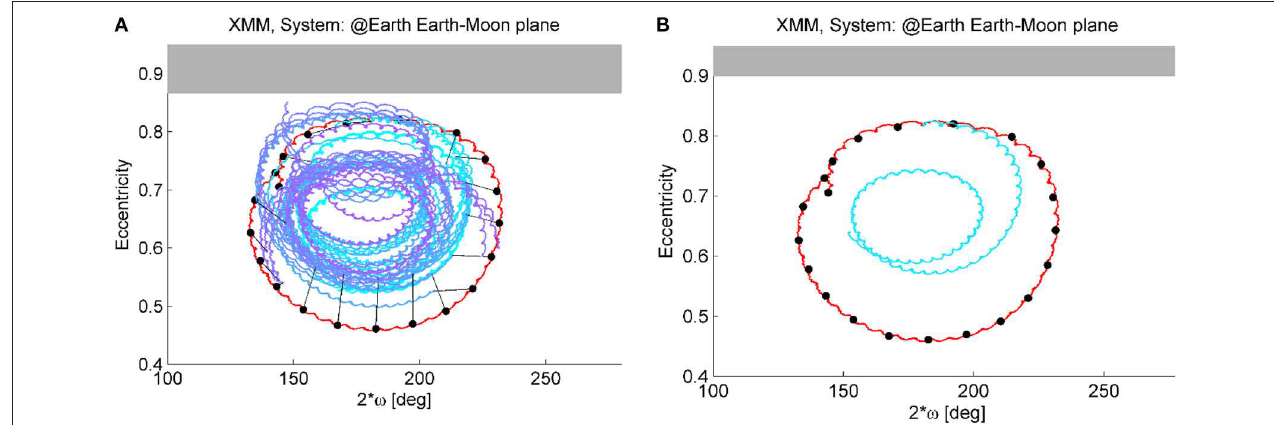
FIGURE 11 | XMM-Newton graveyard disposal. (A) Optimal maneuvers in the eccentricity-2 ω phase space (black points: starting times analyzed for the re-entry disposal). (B) Example of a disposal trajectory (cyan line). The initial inclination and the argument of the perigee are measured with respect to the Moon’s plane.